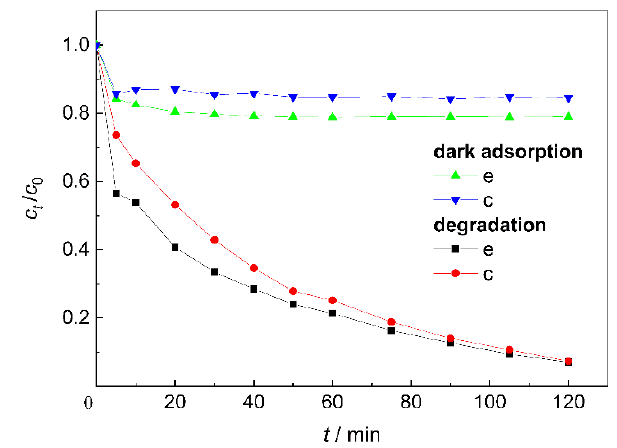
Figure 6. Effect of molar ratio of ZnO to TEA on the photocatalytic performance of ZnO/bone char.